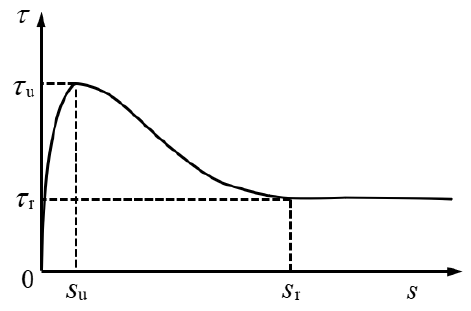
Figure 12. Bond stress-slip curve of Model 3. The shape coefficient α w can be obtained by the fitness of test curves. As presented in Figure 13, the values of shape coefficient α w decreases with the increase of fiber factor and can be expressed as a linear regression formula. However, the correlation of α w and λ f is very low, due to the large variation of the descending portion of curves. This indicates that the shape coefficient α w cannot reflect the effect of steel fiber on the descending portion.